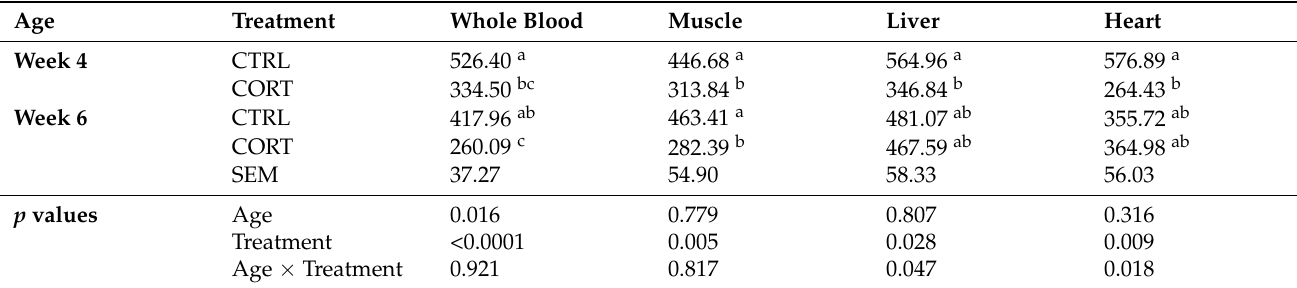
Table 7. Effect of corticosterone feeding and age on absolute telomere length in whole blood, muscle, liver and heart of broiler chicken.